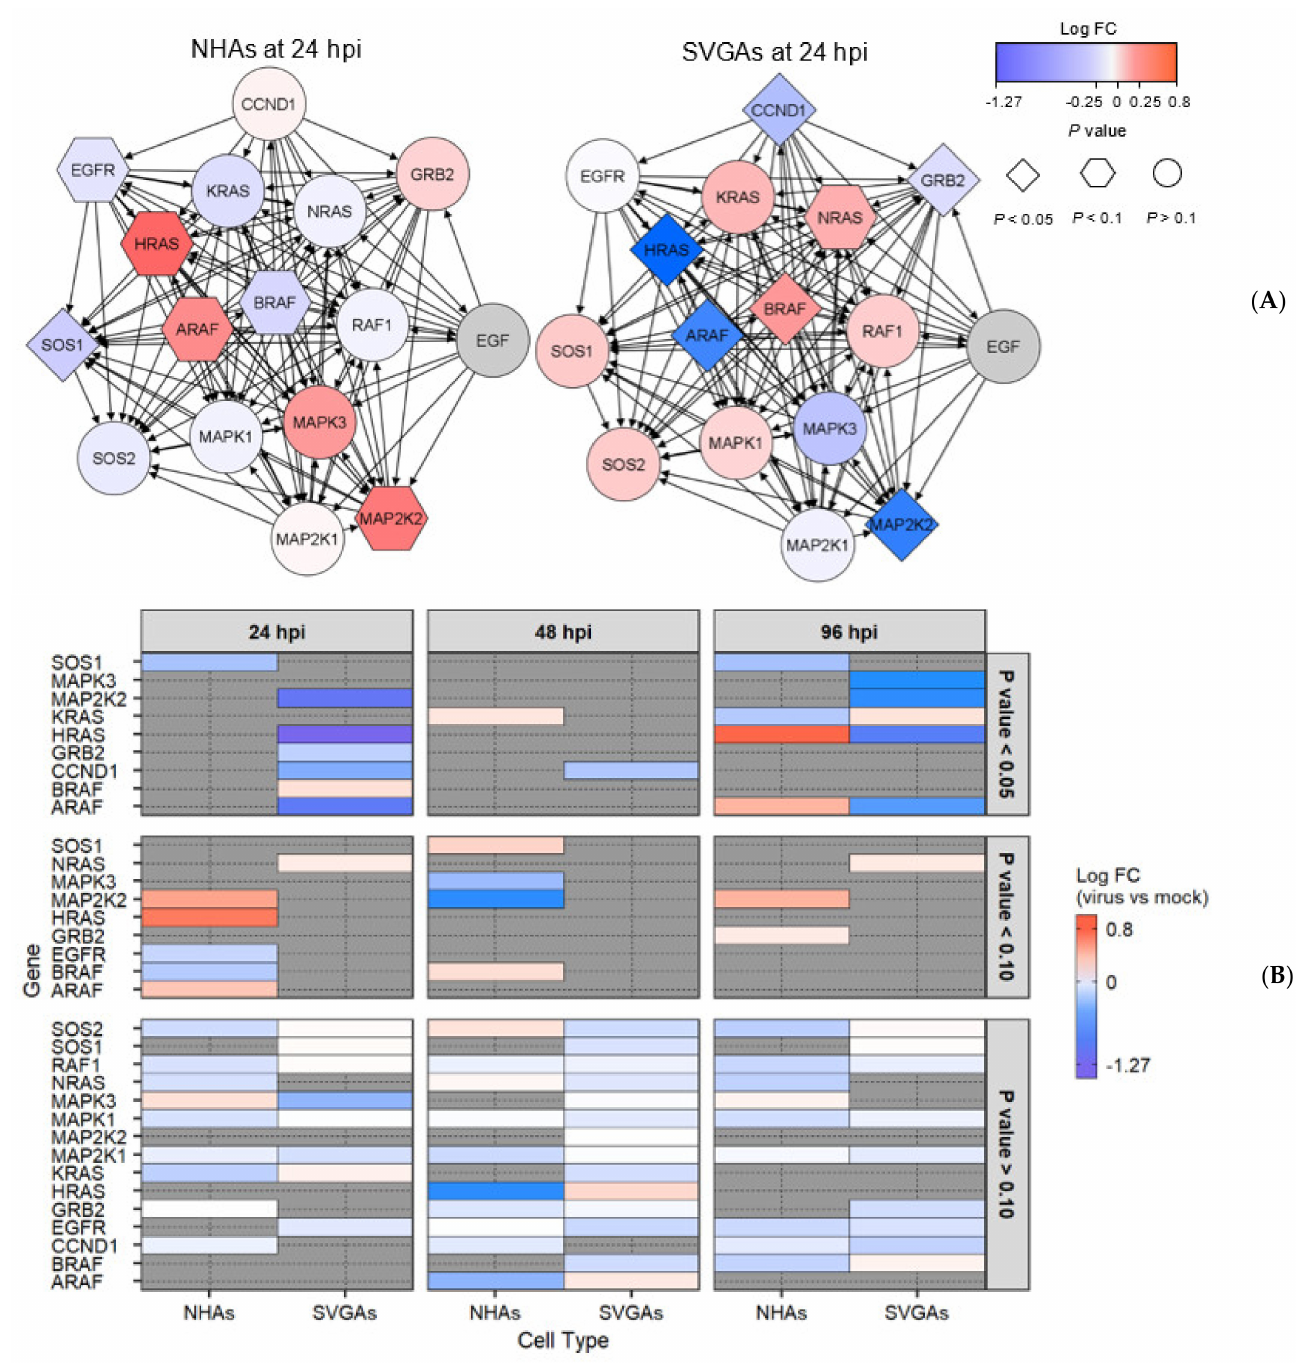
Figure 2. The MAPK/ERK1/2 cascade and associated gene networks are differentially expressed in NHAs compared to SVGAs during JCPyV infection. ( A ) Genes of the MAPK-ERK1/2 were entered into the STRING interaction database to determine the protein–protein interactions determined experimentally or from curated databases of the immediate, surrounding genes within the MAPK/ERK1/2 cascade of NHAs (left) or SVGAs (right). These interactions were defined as having an interaction score of 0.9 with no more than 10 interactors in the 1st and 2nd shell. Each node (i.e., gene) was colored based on the log fold change of JCPyV-infected cells to mock-infected cells at 24 h, and the shape of the gene represents the significance. Arrows point from the source gene to the target gene. Genes colored gray were in the network but were filtered out of the RNA-seq analysis. ( B ) Heat map indicates the Log 2 fold change of JCPyV-infected cells versus mock-infected cells of the genes within the MAPK/ERK1/2 cascade faceted by timepoint (24, 48, and 96 hpi) and p value ( p < 0.05, p < 0.10, and p >